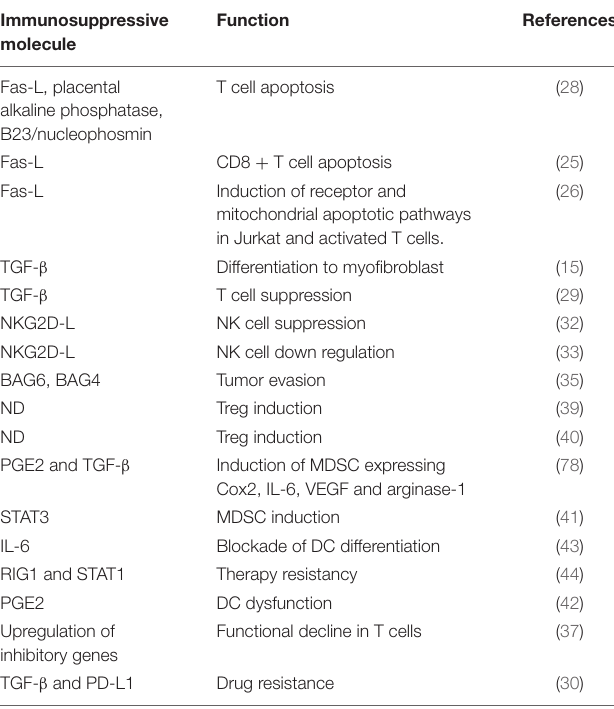
TABLE 1 | Tumor-derived exosomes involved in suppression of the immune response. Immunosuppressive molecule